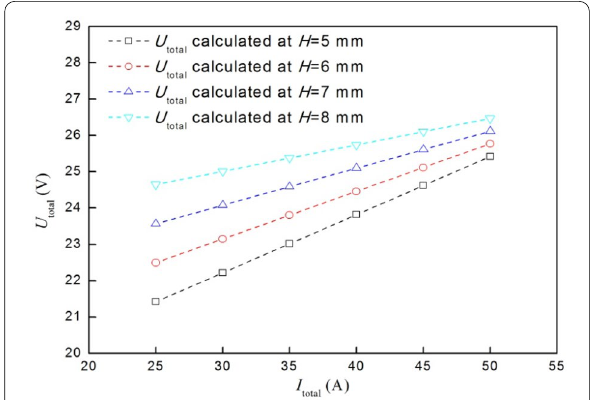
Figure 6 Relationships between calculated total voltage and total current for different torch stand-off distances